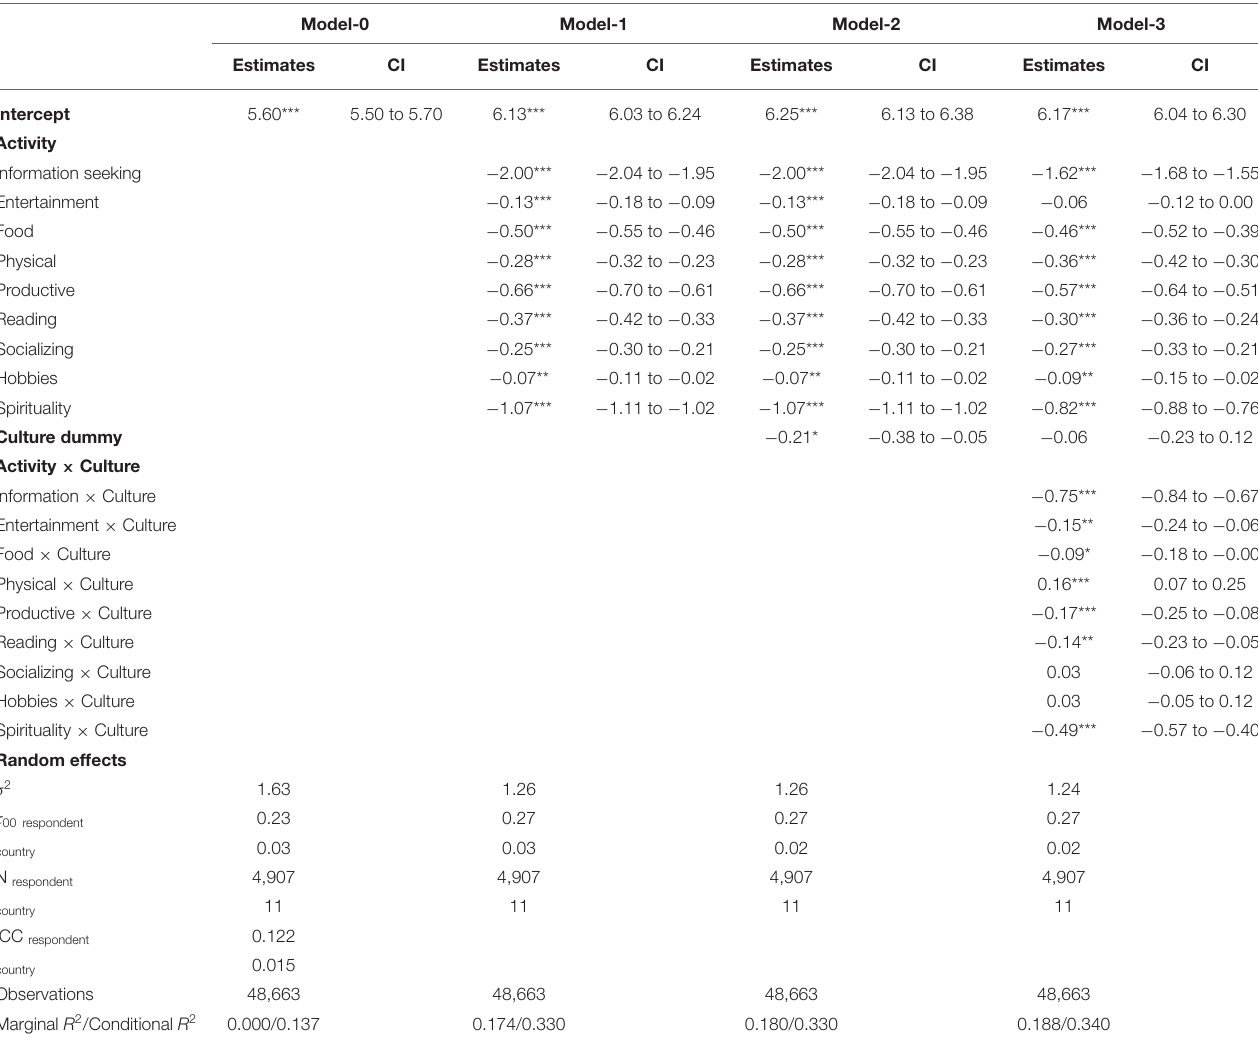
TABLE 3 | Overview of main statistical outcomes of multilevel regression models testing the efficiency of activities in obtaining “Enjoyment and maintaining good mood” by Activity and